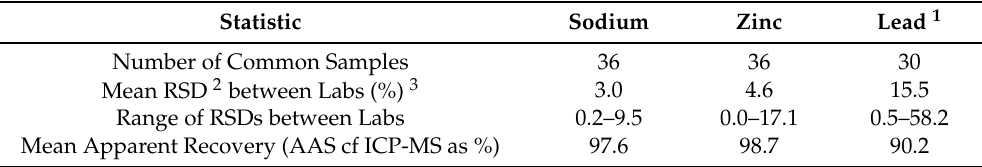
Table 3. Summary of interlaboratory comparison results for sodium, lead, and